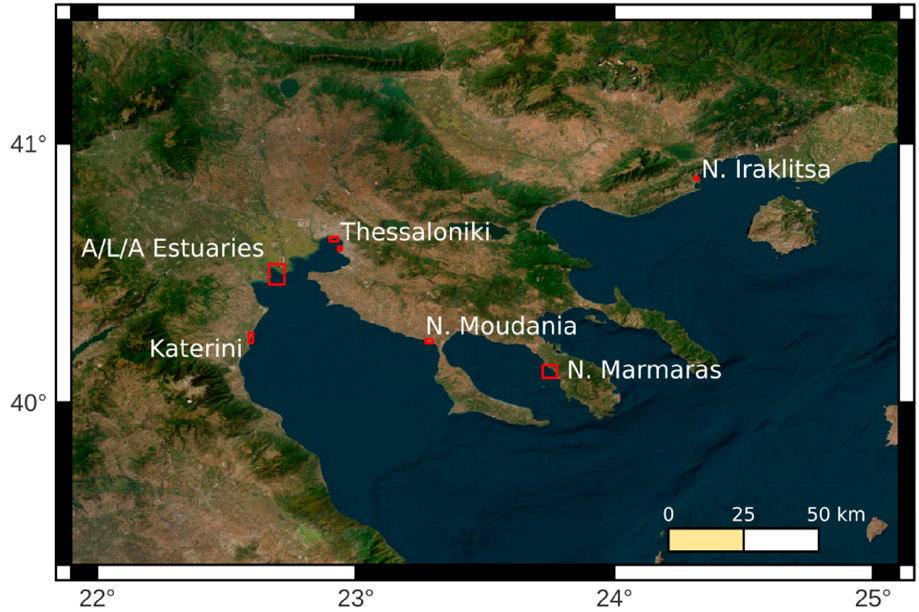
Figure 2. Areas (red rectangles) for validation of DBM. (A/L/A: Axios/Loudias/Aliakmonas) (Basemap: ESRI Imagery).